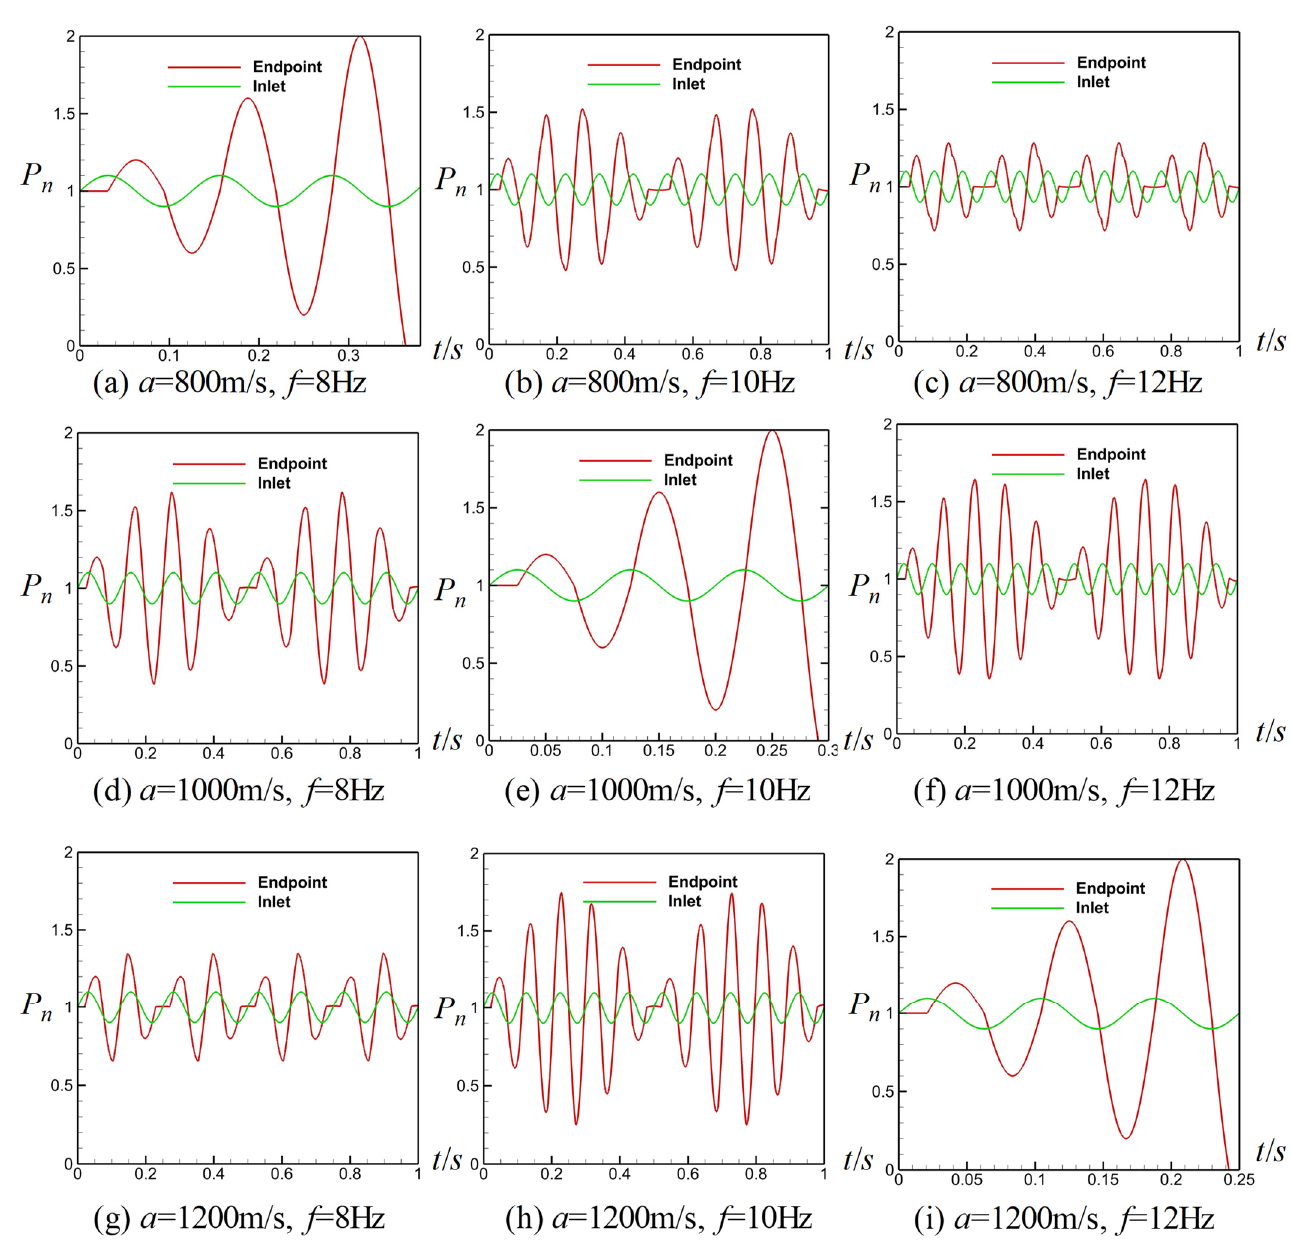
Figure 12. Normalized pressure–time curves where the pipe length is L x = 25 m. The upper part ( a – c ) is obtained when the wave speed is 800 m/s, the middle part ( d – f ) is obtained when the wave speed is 1000 m/s, the lower part ( g – i ) is obtained when the wave speed is 1200 m/s. These phenomena show that the optimal frequency f op depends on the wave speed a